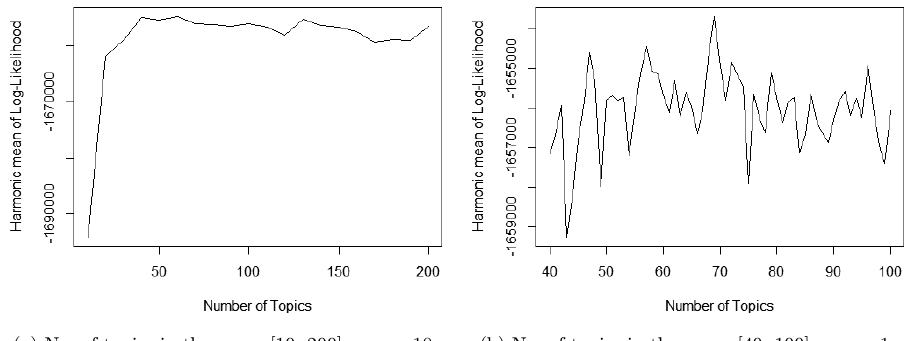
Fig. 4. Log-likelihood for Twitter network.